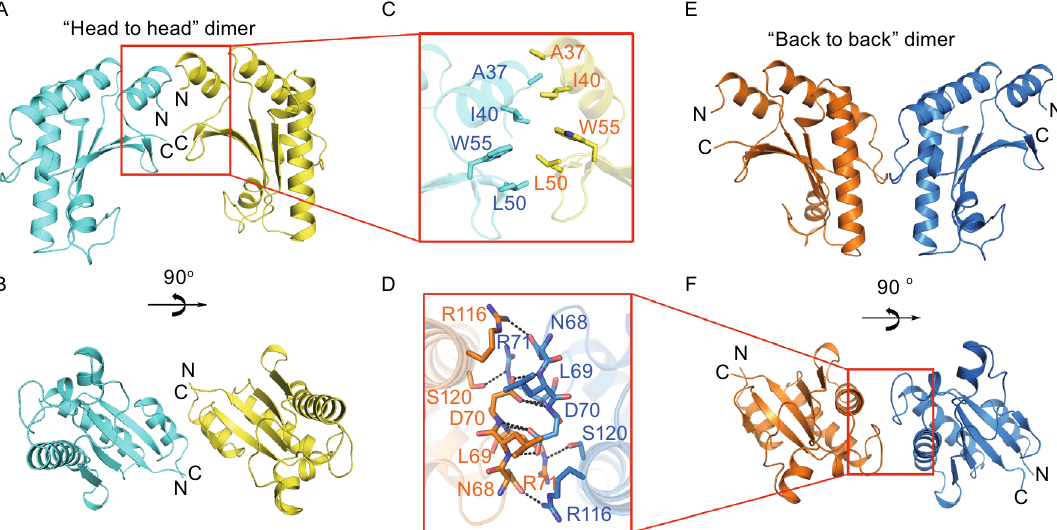
Figure 2. Two dimeric types of Y fi B dimer. (A – C) The “ head to head ” dimer. (D – F) The “ back to back ” dimer. (A) and (E) indicate the front views of the two dimers, (B) and (F) indicate the top views of the two dimers, and (C) and (D) indicate the details of the two dimeric